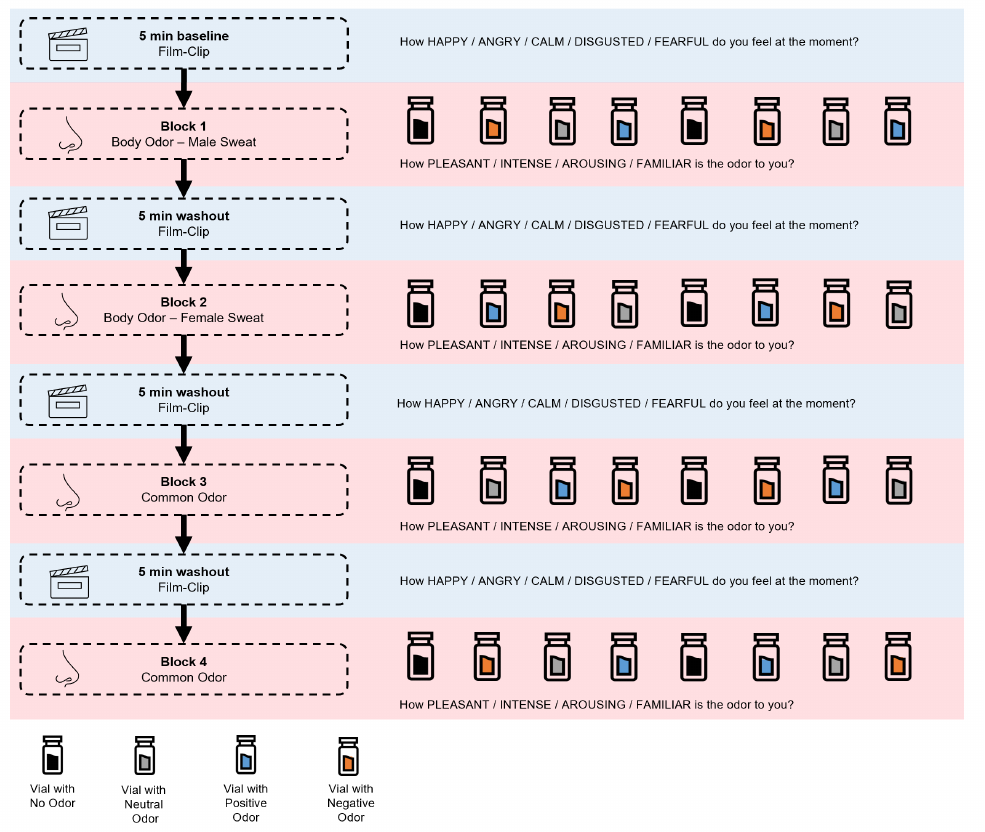
Figure 1. Odour Perception